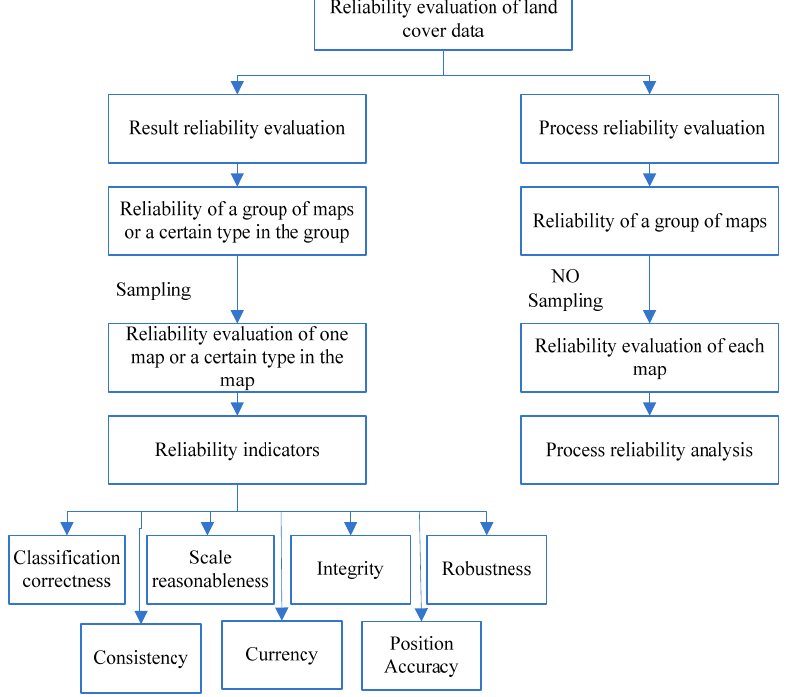
Figure 1. General framework of the reliability evaluation of land cover